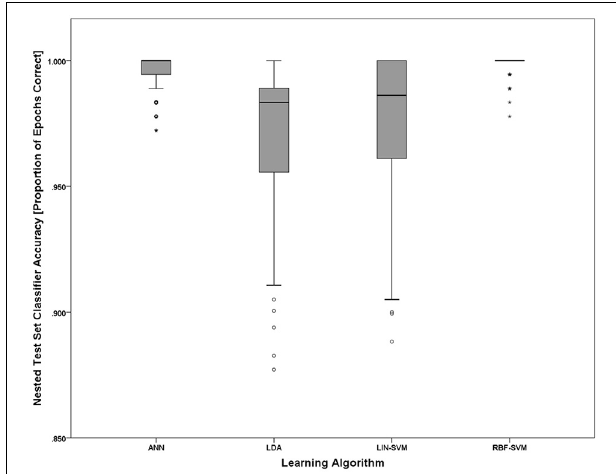
FIGURE 12 | Nested test set accuracy (withheld from S1) for each of the four learning approaches. Noting the y-axis scale of the figure, nested test set accuracies for all learning approaches are at or near ceiling. The boxplots shown represent the median (line inside the box), first and third quartiles (bottom and top of the box, or the lower and upper hinges, respectively), and minimum and maximum values (lower and upper whiskers, respectively, or inner fences). Outliers exceeding 1.5 times the box height are shown as individual sample points (circles). Extreme outliers, or those samples exceeding 3 times the box height, are indicated by